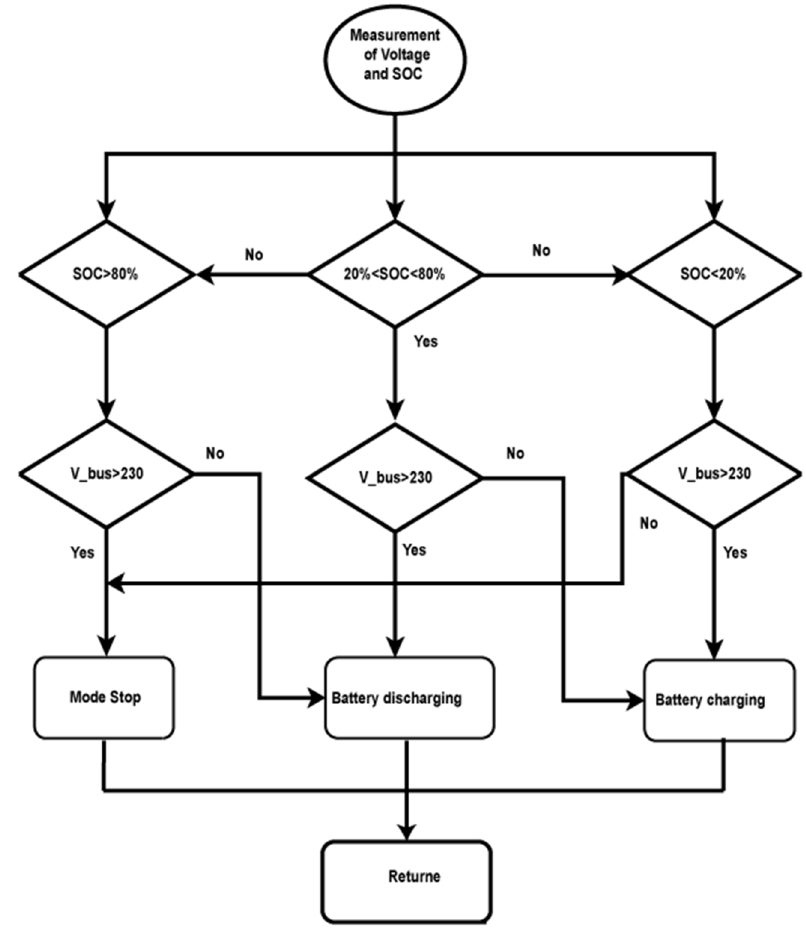
Figure 9. Flowchart of the energy management strategy.